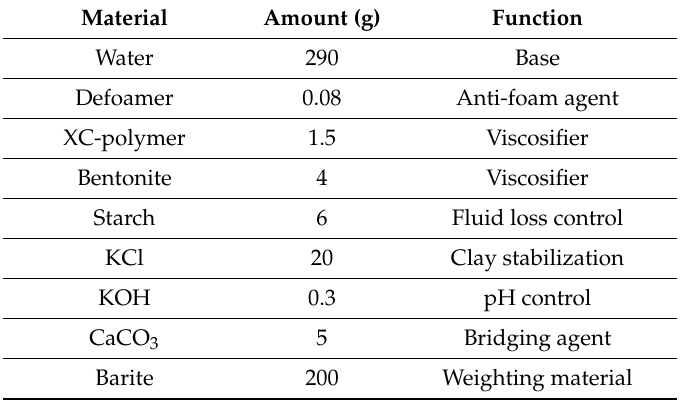
Table 2. Barite-weighted water-based mud (WBM) formulation.